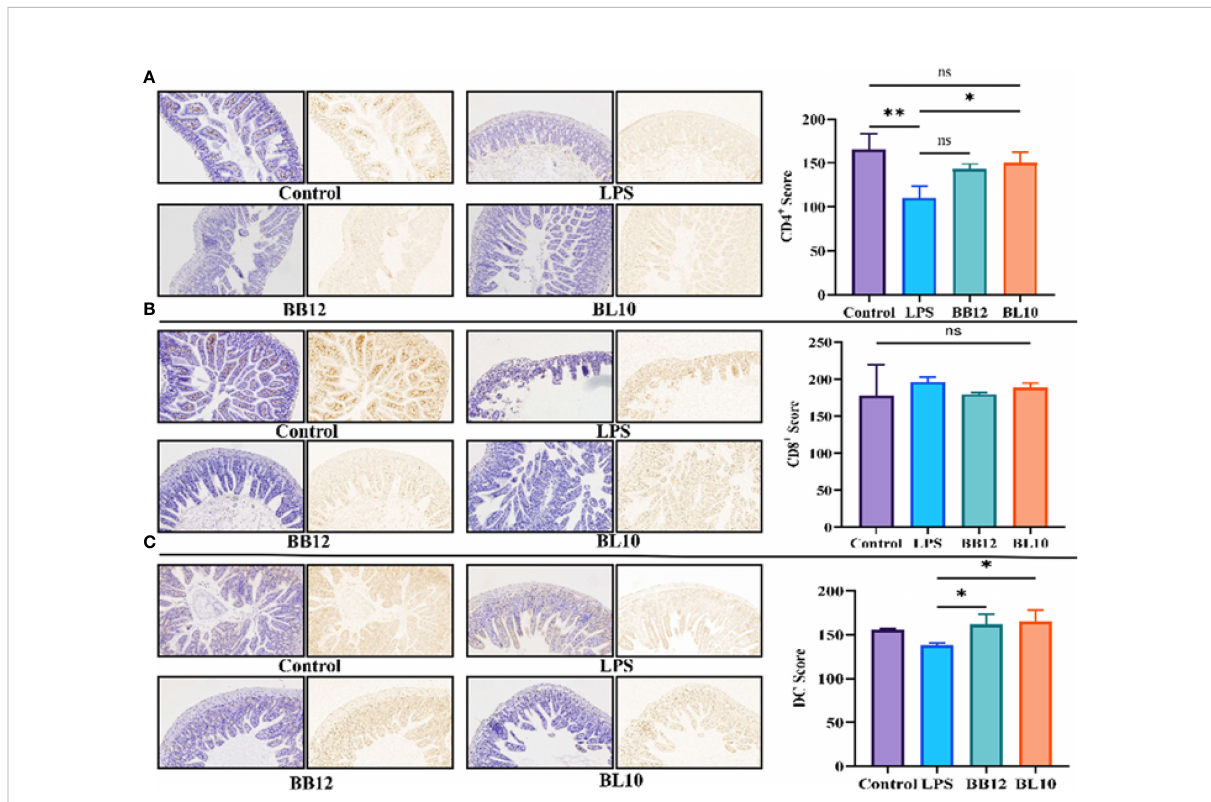
FIGURE 5 Effect of B longum BL-10 on ileal DCs, CD4+ and CD8+ T cells. (A) CD4 + T cells; (B) CD8 + T cells; (C) DC cells. All data are expressed as mean ± SD (n=3). Values with a different superscript letter (*, ** and ns) were signi fi cantly different at p <0.05, p <0.01 and p